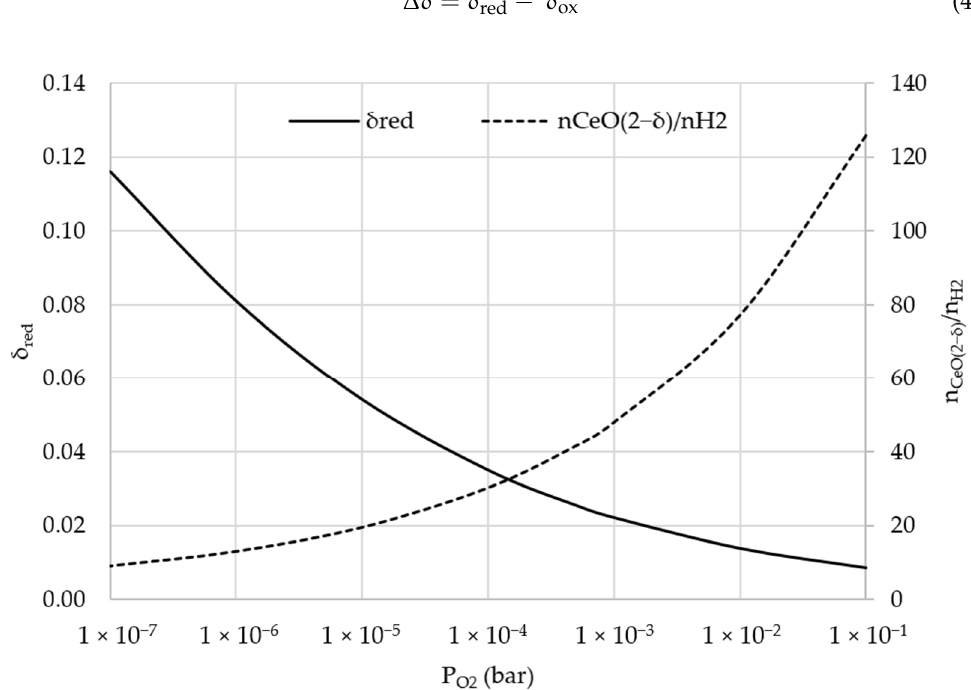
Figure 1. Dependency at 1500 °C between oxygen partial pressure (P O2 ) and reduction extent (δ red , left axis) and quantity of ceria per mole of hydrogen (n CeO(2-δ) /n H2 , right axis) according to Bulfin et al. [21].